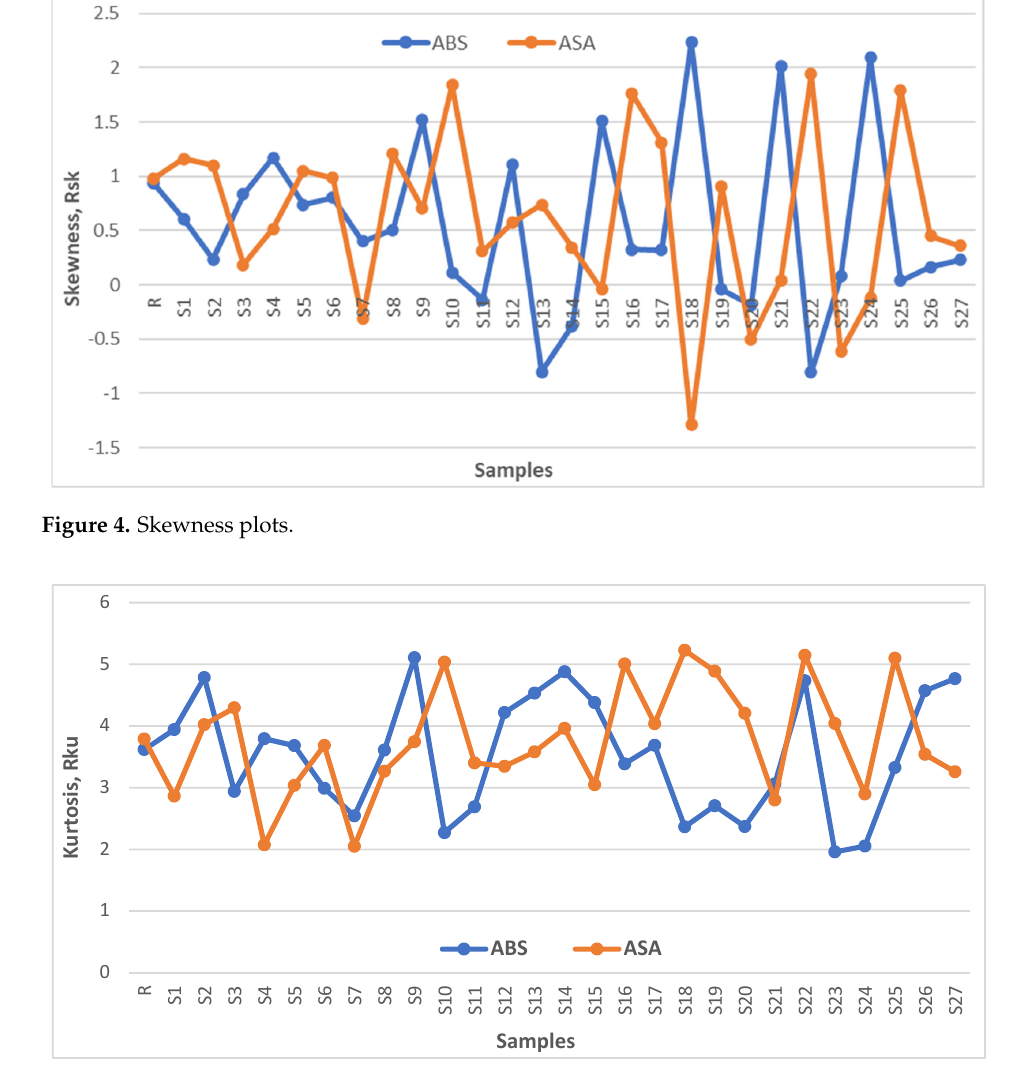
Figure 5. Kurtosis plots.